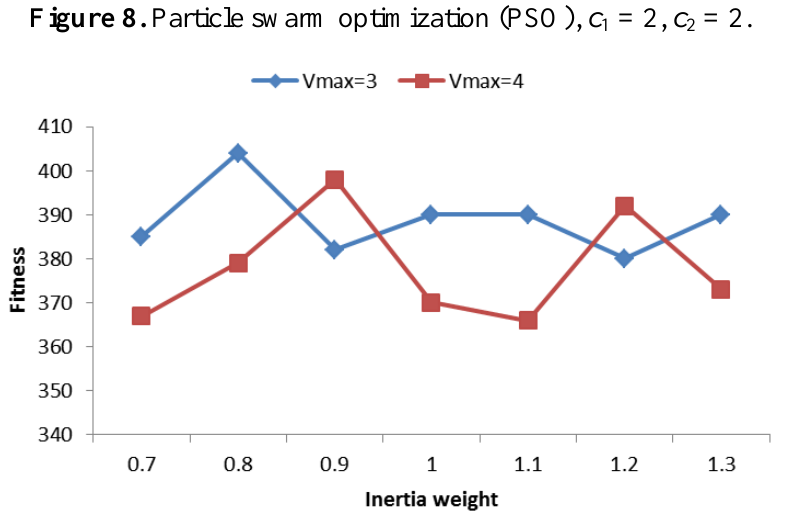
Figure 8. Particle swarm optimization (PSO), c